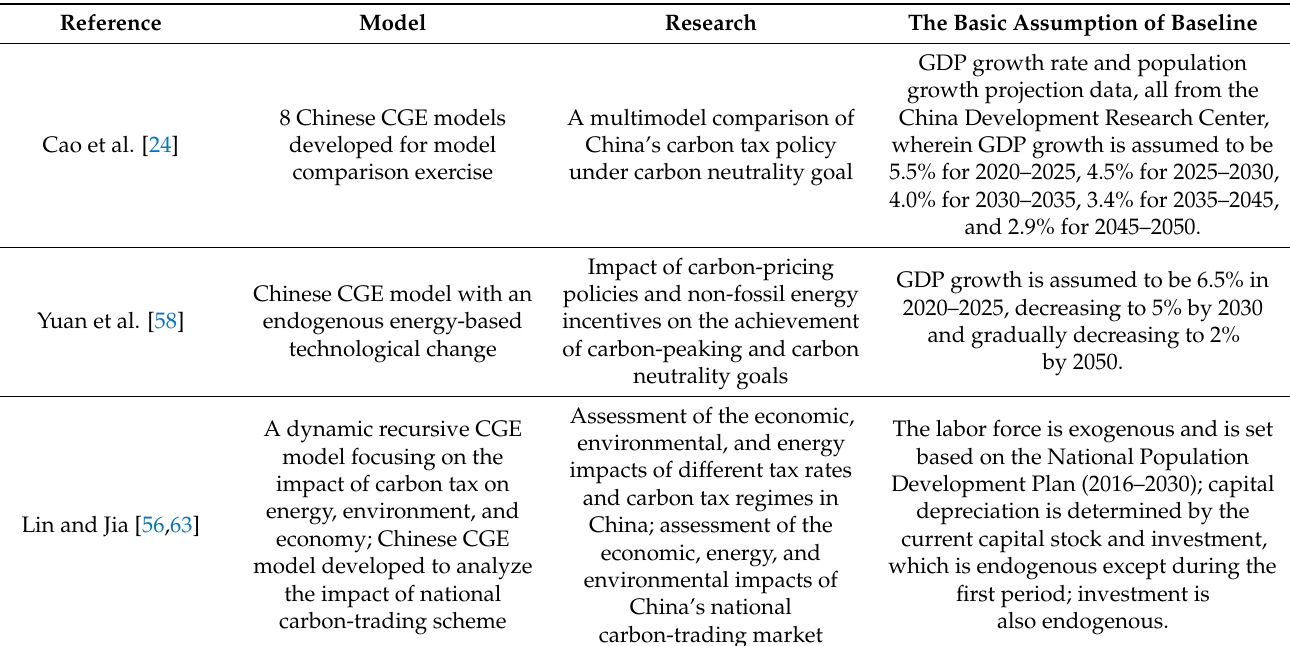
Table 2. Comparison of CGE model baseline